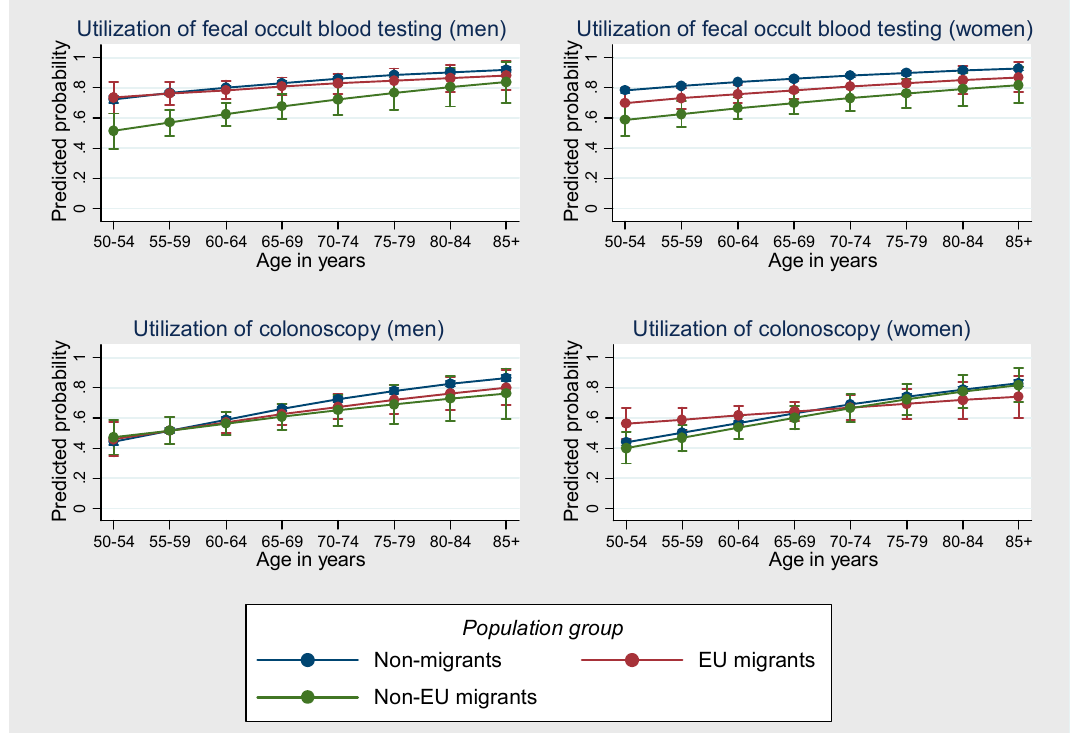
Figure 1. Probability of the utilization of fecal occult blood testing and colonoscopy by population group, sex and age. Results of the multivariable logistic regression models with interaction effects between population group, sex and age. Predicted probabilities (German Health Update 2014/2015, respondents aged ≥ 50 years, n = 11,757).